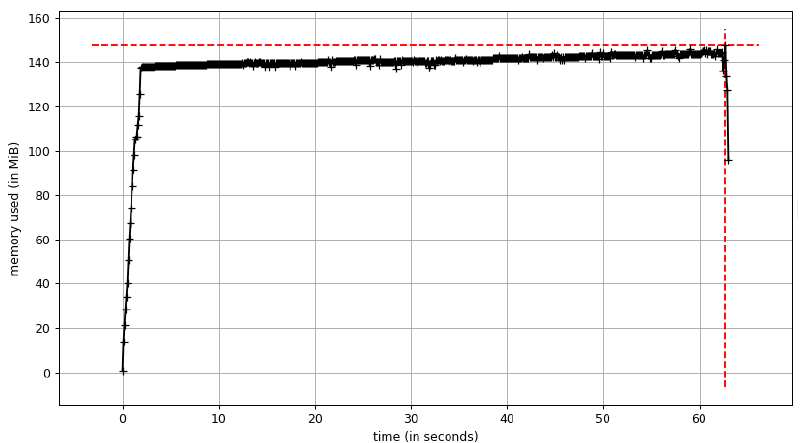
Figure 19. Memory profile results of SFSDT model to select the best feature subset on NSLKDD